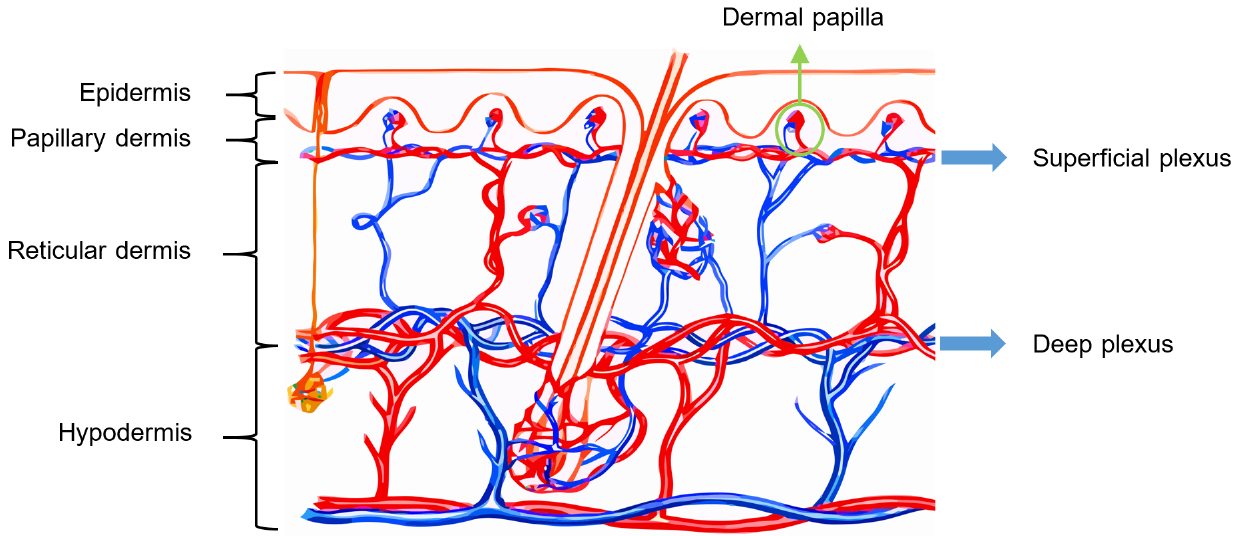
Figure 5. Scheme of the vascularization of the skin. Based in [62,63].